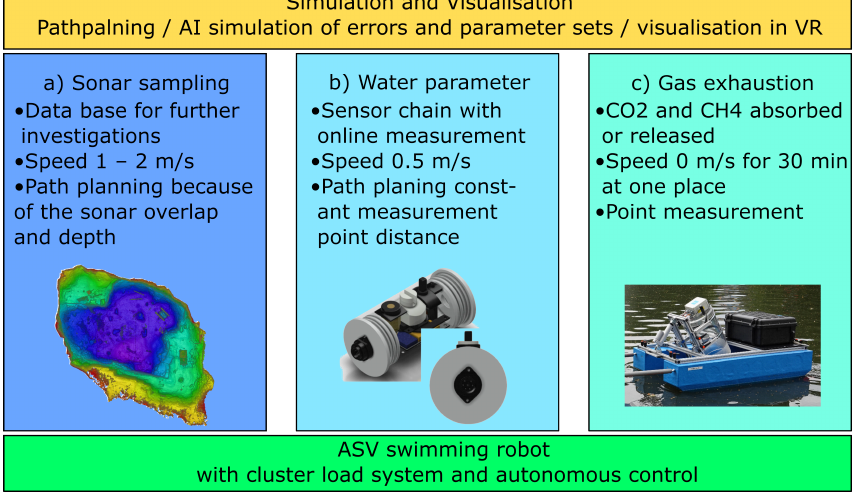
Figure 2. Show the foundation of the hardware base as the swimming robot (Section 2.2), the three different measurement cases of the sonar sampling (Section 3.1), the water parameter (Section 2.4) and gas exhausting measurement (Section 2.4) with the roof of the software functions (Section 4) and